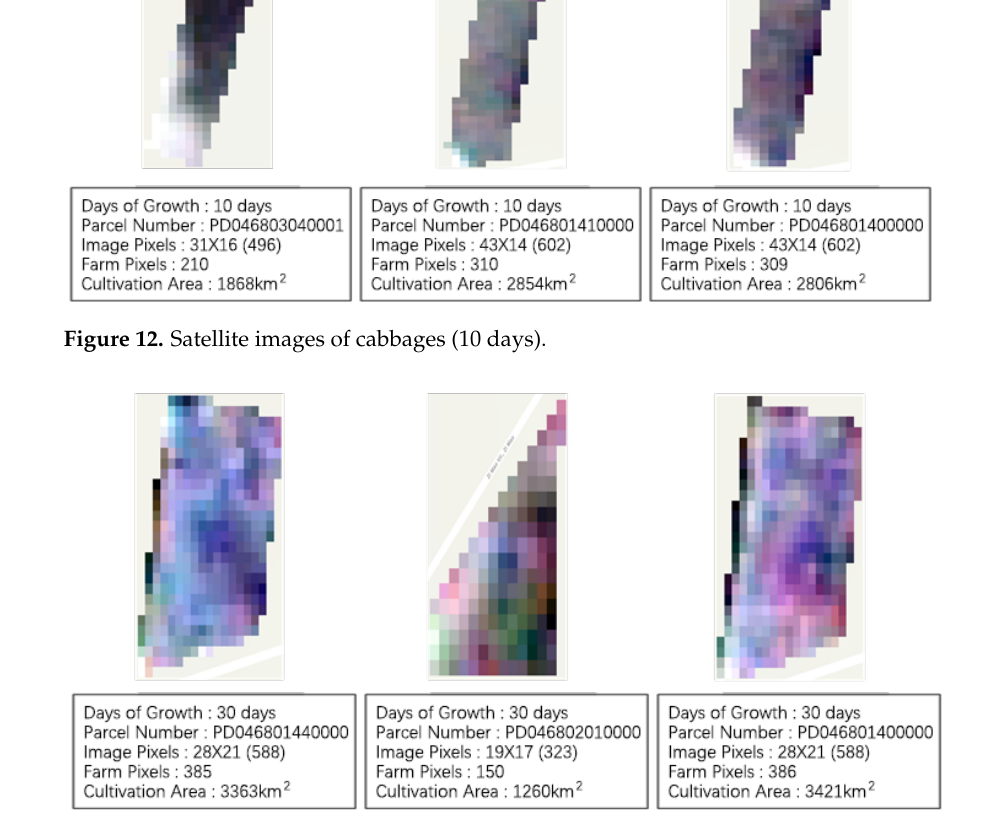
Figure 13. Satellite images of cabbages (30 days).